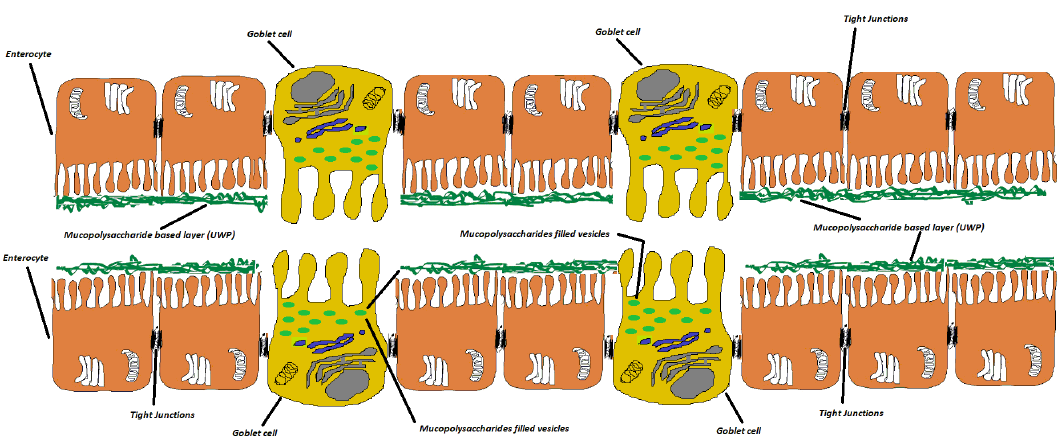
Figure 1. Representation of UWP in the intestine. It is possible to recognize tight junctions and Goblet cells.